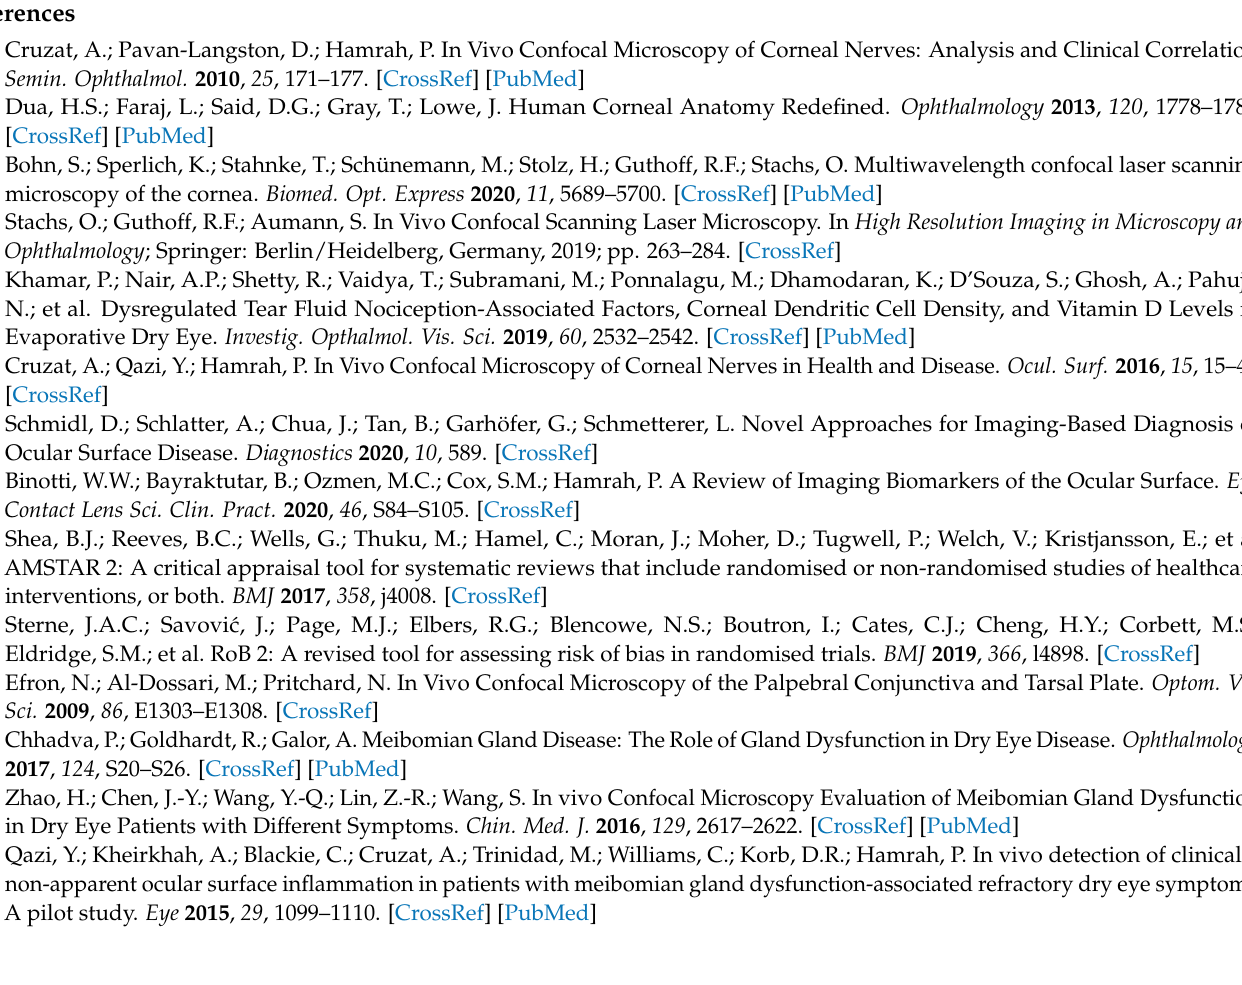
Electronic Searches. Table S1: Table to summarize the results of AMSTAR-2. Table S2: Risk of bias summary for individual studies (n = 4) in accordance with